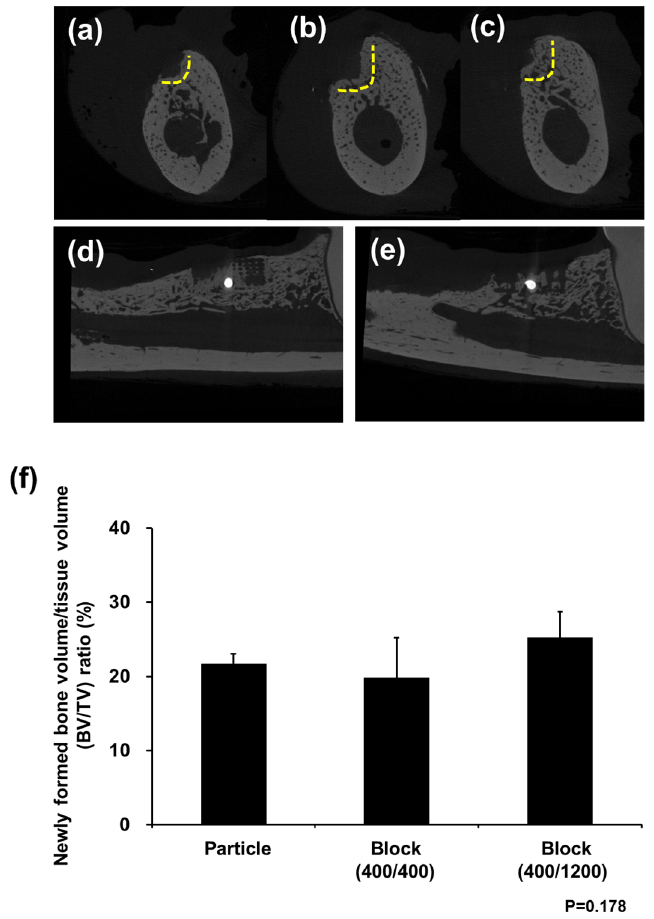
Figure 3. Micro CT images after in vivo experiments. New bone formation was observed above the bottom of the defects (yellow line) in all groups: ( a ) Particle group; ( b ) Block 400/400 group; and ( c ) Block 400/1200 group. The PCL block was radiolucent in micro CT images, and new bone formation between lattices was observed in both the ( d ) Block 400/400 and ( e ) Block 400/1200 groups; ( f ) Bone volume ratio (%) was not significantly different between the groups.